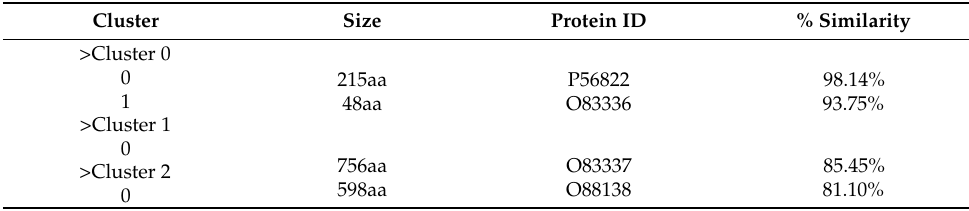
Table 1. The CD-HIT suite identified paralogous proteins using an 80%